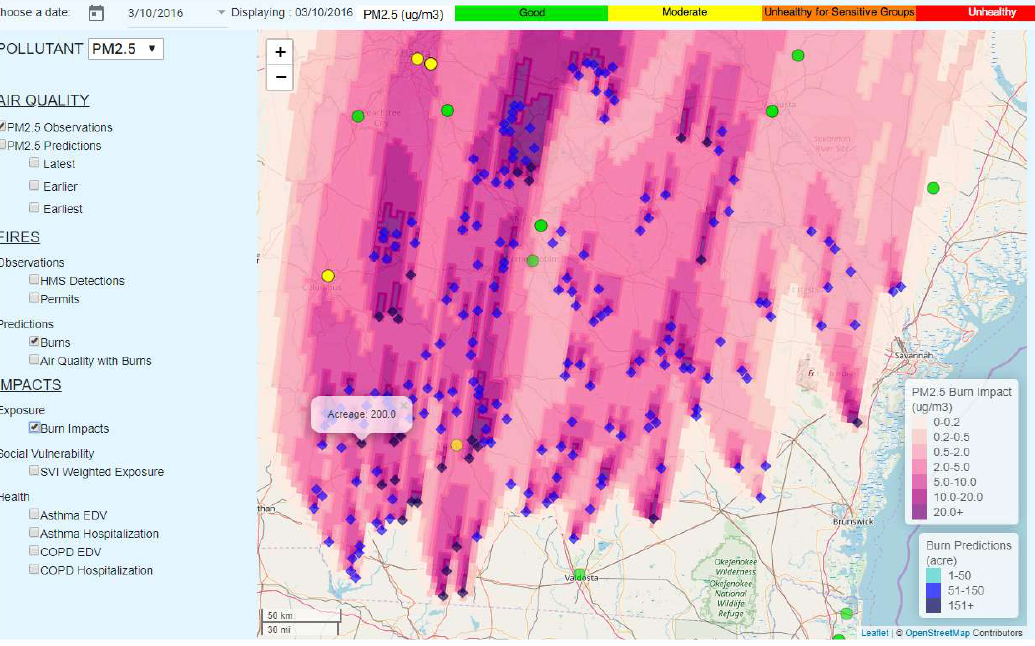
Figure A3. The SIPFIS webpage displays forecasted burns as blue diamonds (in three different shades), overlaid with burn impact forecasts (i.e., increased PM 2.5 concentrations due to burn impacts). 9. Check the box “Air Quality with Burns” to overlay the map of the predicted air quality with the prescribed burn emissions added (Figure A4).